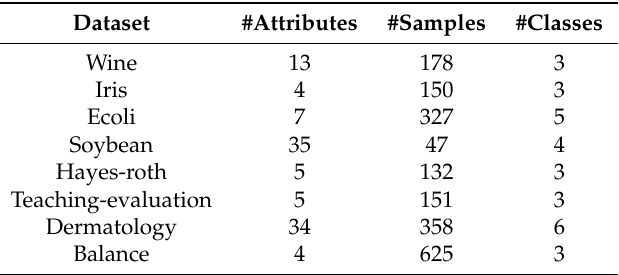
Table 2. The statistics of benchmark